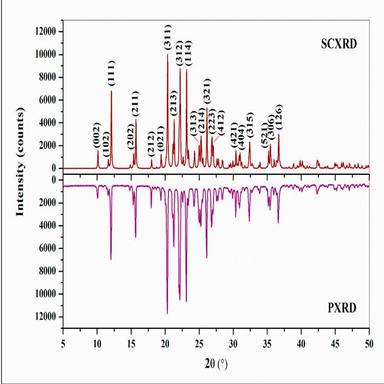
Comparison of Powder XRD patterns of GuHM from Mercury software and from PXRD experiment.